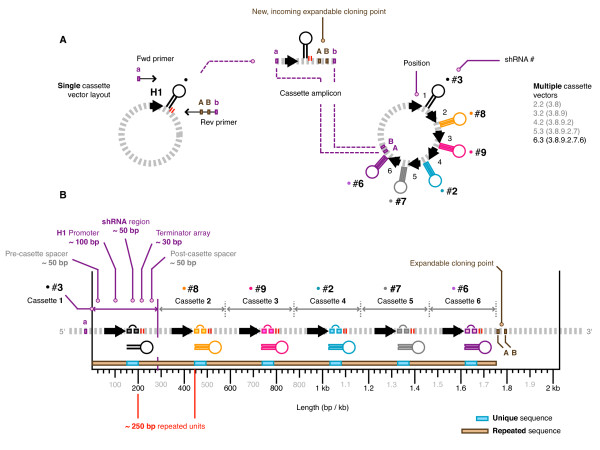
shRNA cassette configuration. (A) Each single shRNA was originally expressed from a human H1 (pol III) promoter in separate vectors. Multiple cassette combinations were made by PCR amplifying each promoter-shRNA-terminator (plus ~100 bp of common flanking sequence) as a self-contained expression cassette, and sequentially inserting them into a single vector via an infinitely expandable cloning strategy. The PCR amplified shRNA expression cassette was digested with 'a' (Mlu I) and 'b' (Asi SI) restriction enzymes (REs) and was ligated to the recipient vector opened up with 'A' (Asc I) and 'B' (Pac I) REs destroying the original 'a', 'A', b', and 'B' sites in the process. The newly created vector has the 'A' and 'B' sites reconstituted via the incoming donor fragment, ready for insertion of subsequent cassettes. The series selected for this study begins with shRNA #3, followed by #8 to make combination 2.2 (shRNA #3.8). Additional shRNAs were added in order to make the combinations 3.2 (#3.8.9), 4.3 (#3.8.9.2), 5.3 (#3.8.9.2.7) and 6.3 (#3.8.9.2.7.6). (B) The average cassette length was ~300 bp long, of which 250 bp (83%) was repeated since each expression cassette was transferred into combination using generic primers.